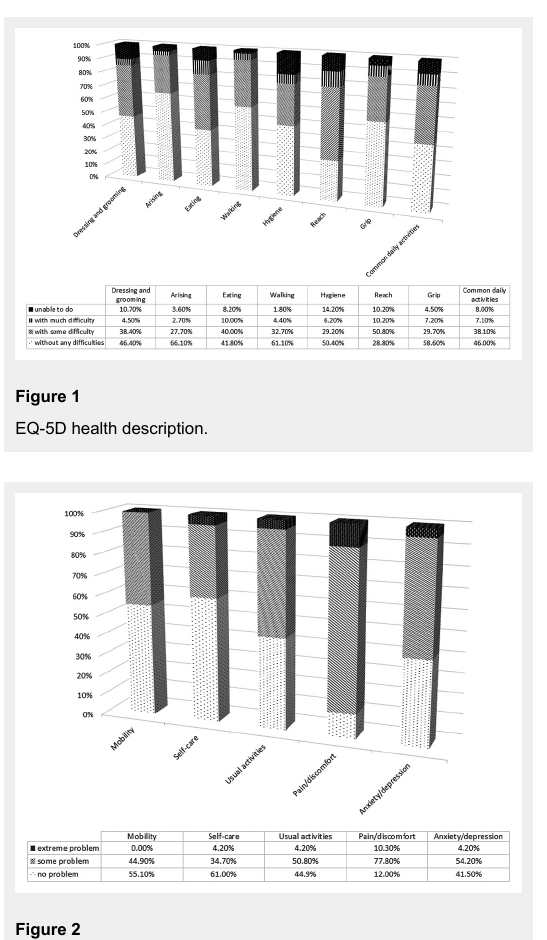
Health assessment questionnaire (HAQ)health description.